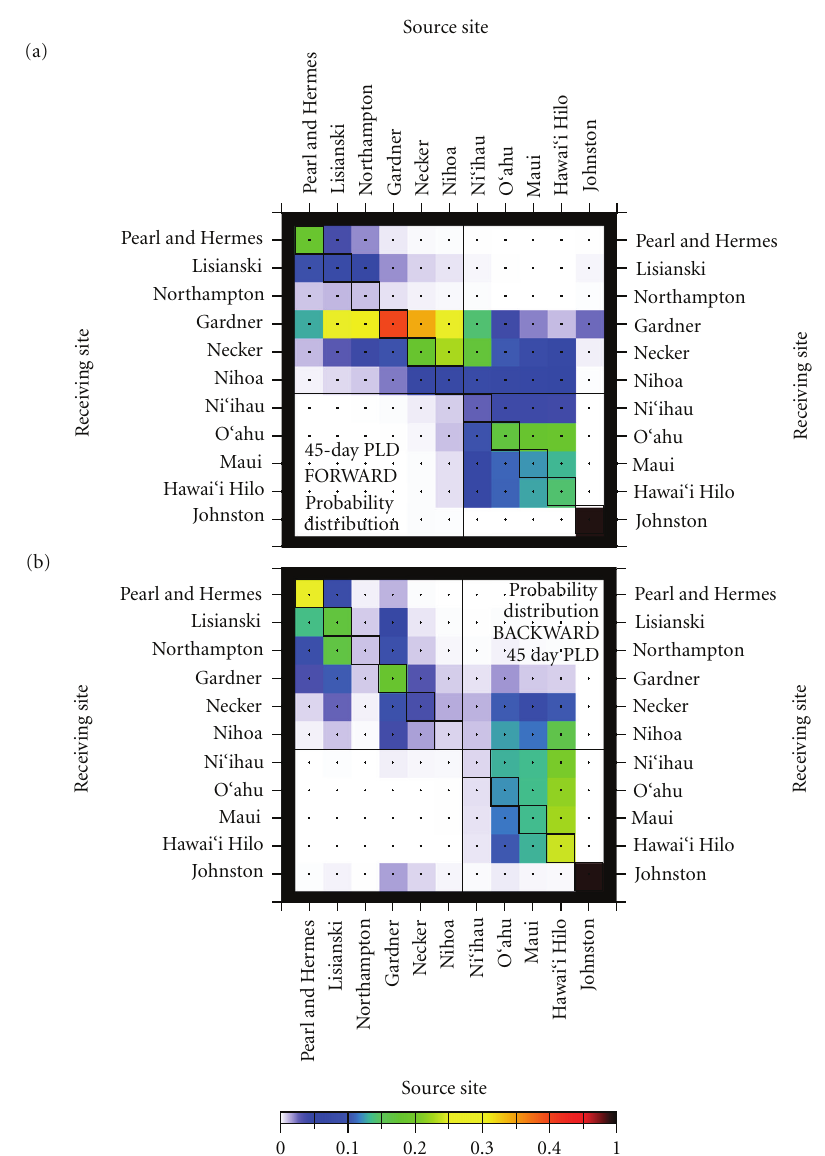
Figure 4: (a) Forward and (b) backward projections of multigenerational settlement probabilities for a 45-day PLD. Values are an average of five runs of the 1,000-generation model. The horizontal and vertical lines separate Main Hawaiian Islands and Northwestern Hawaiian Islands, and the diagonal shows